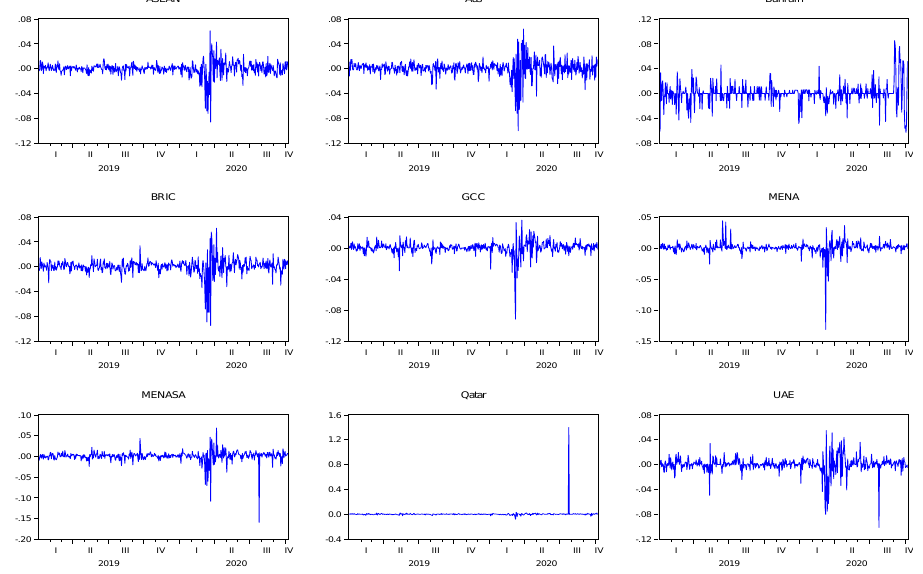
Figure A2. Full period. Source: authors’ calculation using EViews 10.